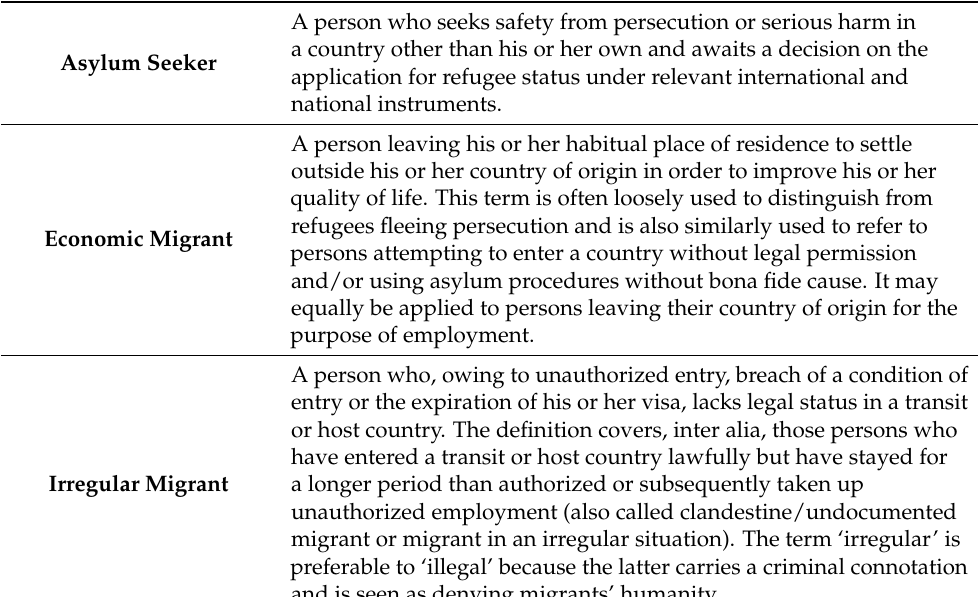
Table 1. Defining common migrant terminology, adapted from International Organization for Mi- gration (Reprinted/adapted with permission from ref. [8]. Copyright 2021, J. Redpath-Cross & R.